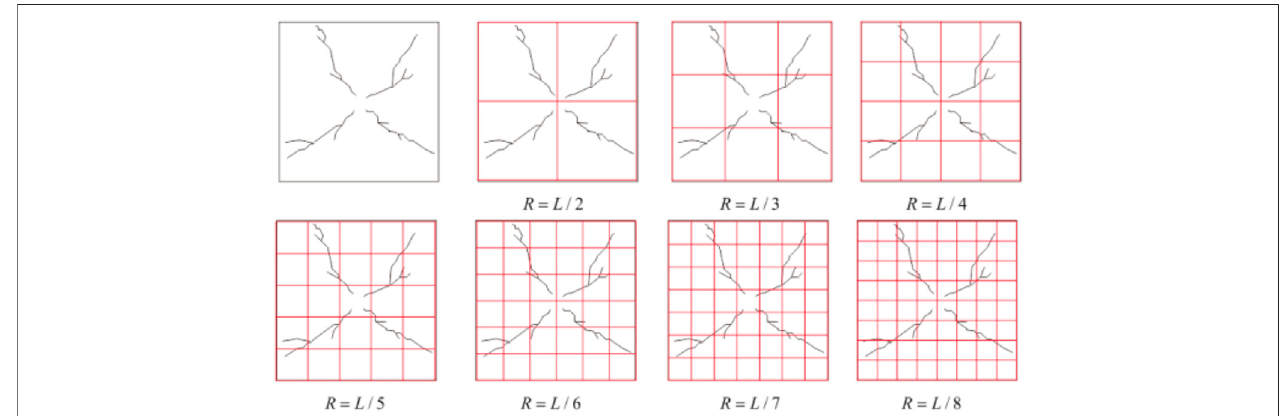
FIGURE 2 | Fracture distribution in different squares.